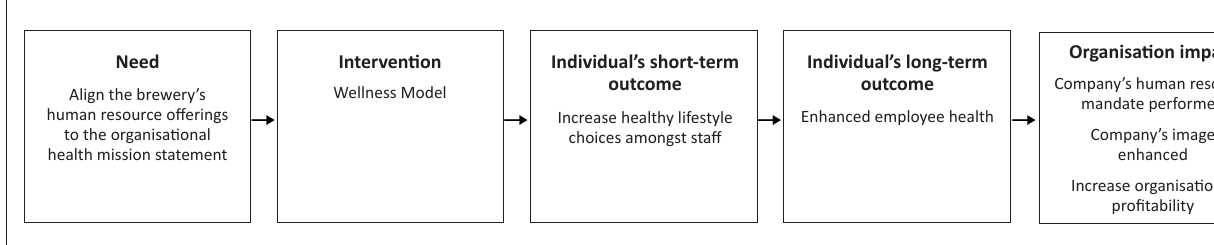
FIGURE 1: Draft version of the Wellness Model’s programme theory.